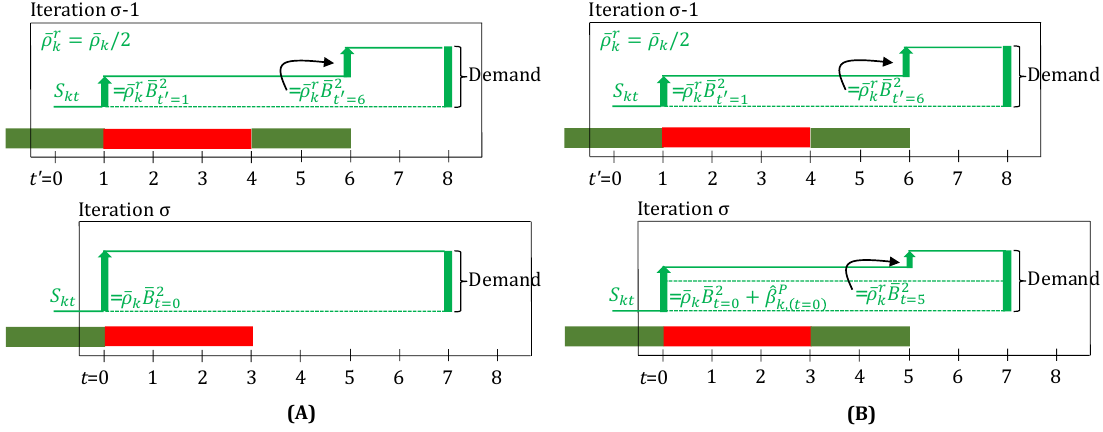
Figure 8. In iteration σ − 1, the green task ( τ = 2) with a “large batch” is finishing at t (cid:48) = 1, but, due to the use of ¯ ρ r , is anticipated to produce only half of what the demand is. Thus, another identical k green task is scheduled to start at t (cid:48) = 4, to satisfy the demand. With the use of ¯ ρ r , if the demand could k be still be satisfied with a single “large” batch, a second batch wouldn’t be scheduled. In iteration σ , the earlier green task yields a large amount of material, in line with its large batch-size due to the true value of ¯ ρ ik used at t = 0. ( A ) Since, here, there was no material handling loss, thus the second green task need not run now, as the demand was satisfied by the first batch itself. ( B ) Although the green < 0) at t = 0, requires the task results in a large yield at t = 0, a small material handling loss ( β P k ( t = 0 ) second green task to still be scheduled in order to meet the demand, but now with a smaller batch-size. If there are no further material handling losses, there would be a small excess inventory of material produced by the second green task, since its batch-size was decided assuming the yield to be lower (¯ ρ r ) k but would in reality by higher (¯ ρ k